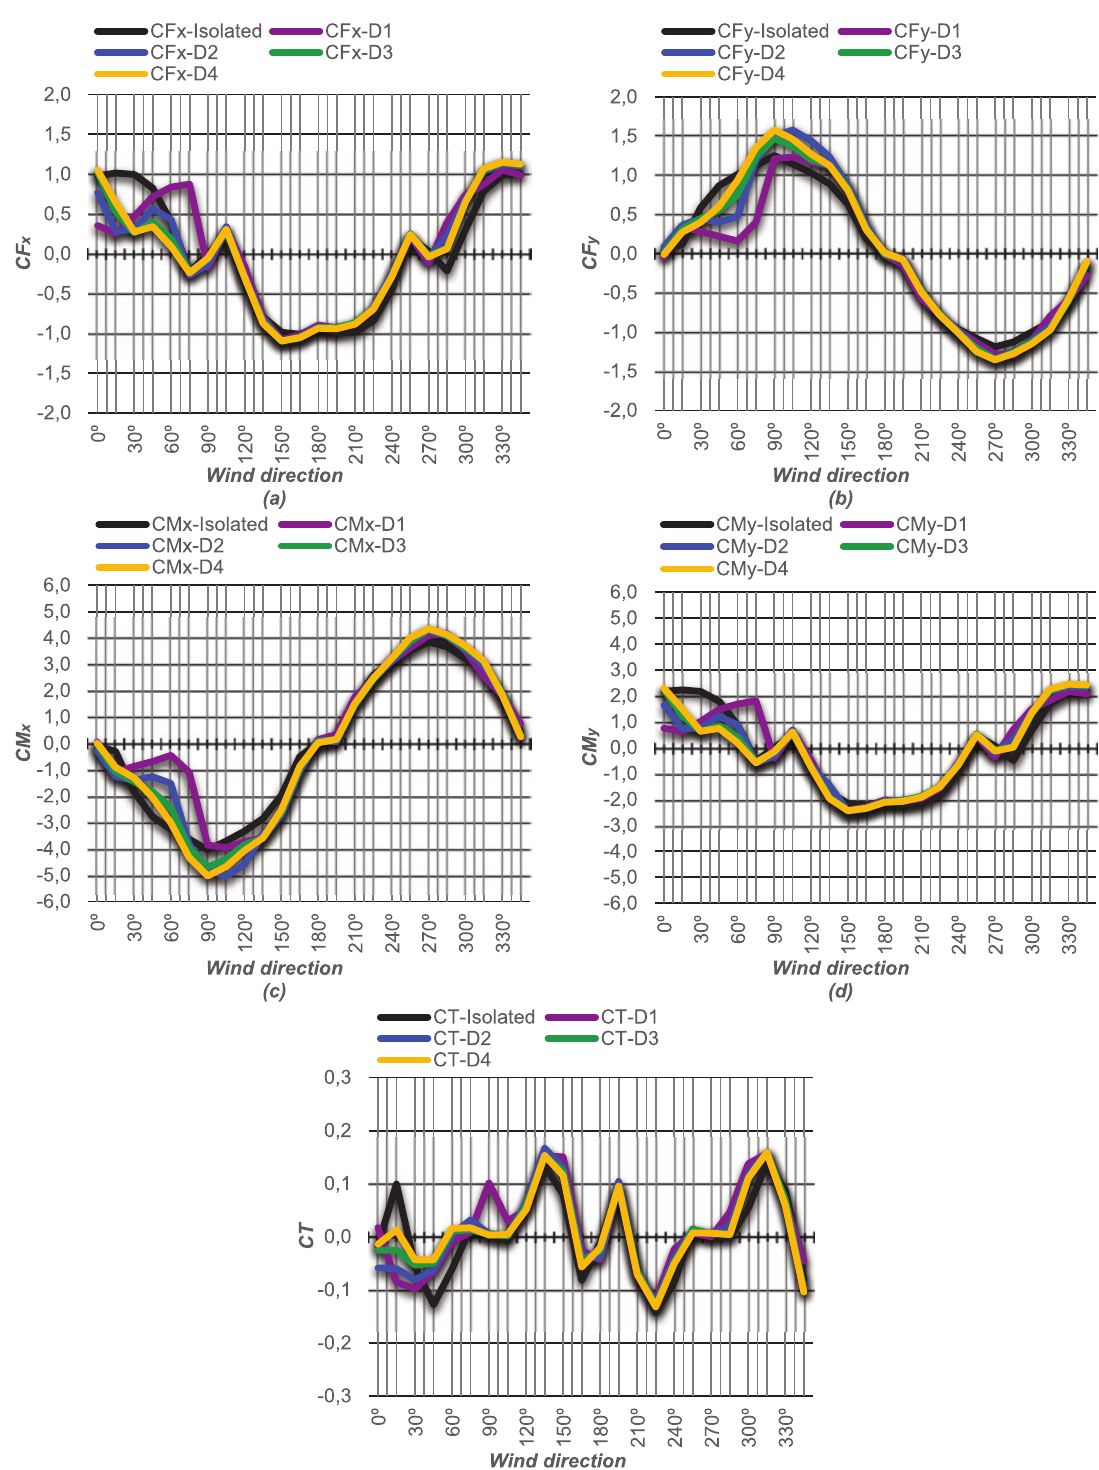
Figure 12 Load coefficients for the vicinity V5: (a) Resultant force in the direction of the X axis; (b) Resultant force in the direction of the Y axis; (c) Base momenta round axis X; (d) Base moment around axis Y; (e) Torsion around building